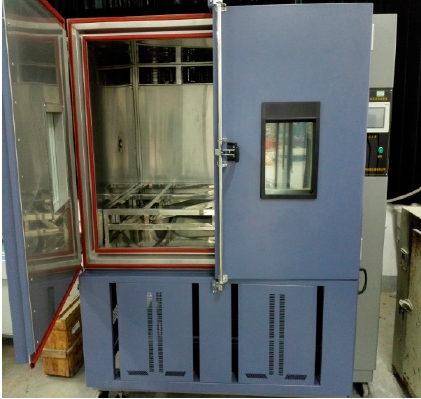
Figure 2. Programmable temperature and humidity alternating test chamber (ETE ‐ GDJS ‐ 015L).